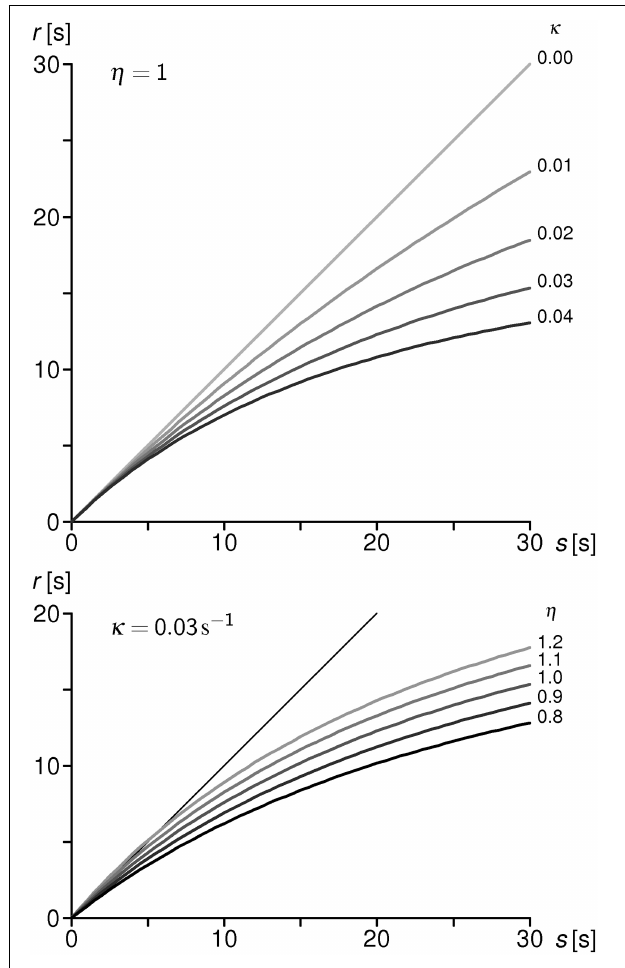
FIGURE A1 | Upper part: different forms of the KRF for η = 1 (equal inflows) and κ varied from 0 to 0.04 with step 0.01. The higher the loss coefficient κ , the more pronounced is the KRF curvature, i.e., the progressive shortening with increasing duration s . Lower part : different forms of the KRF for a constant value of κ = 0 . 03 and η varied from 0.8 to 1.2 with step 0.1. The curvature is basically determined by κ and further modulated by the inflow ratio η .—ISI in both displays are constant 0.5s. Thin diagonal line indicates the chronometrically correct response r = s